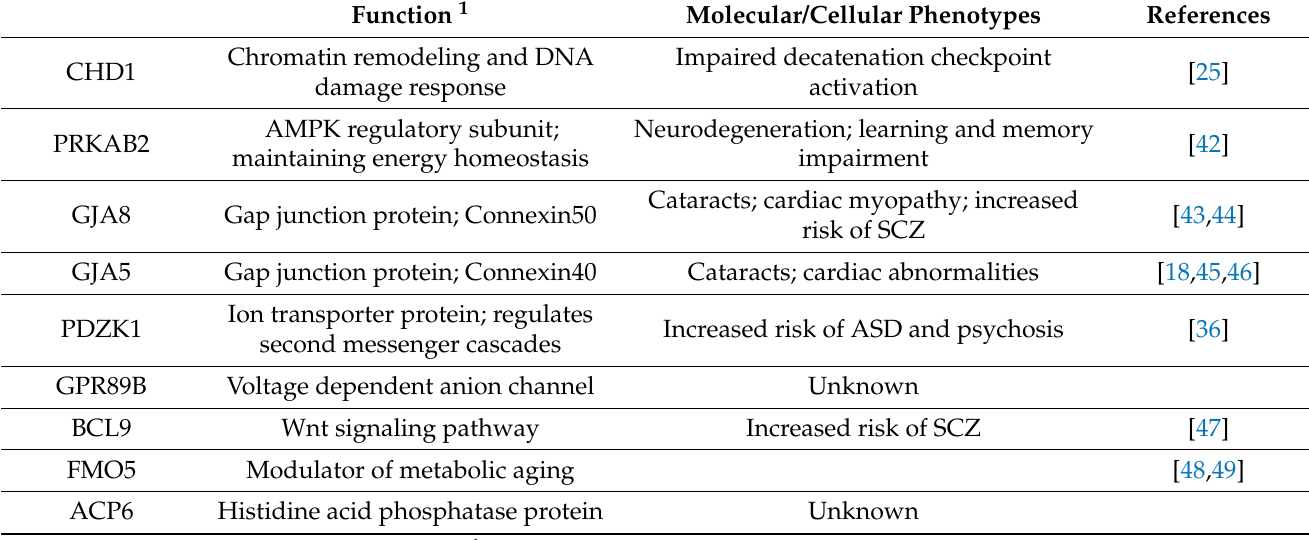
Table 1. Genetic function and known phenotypes of dosage-sensitive genes associated with